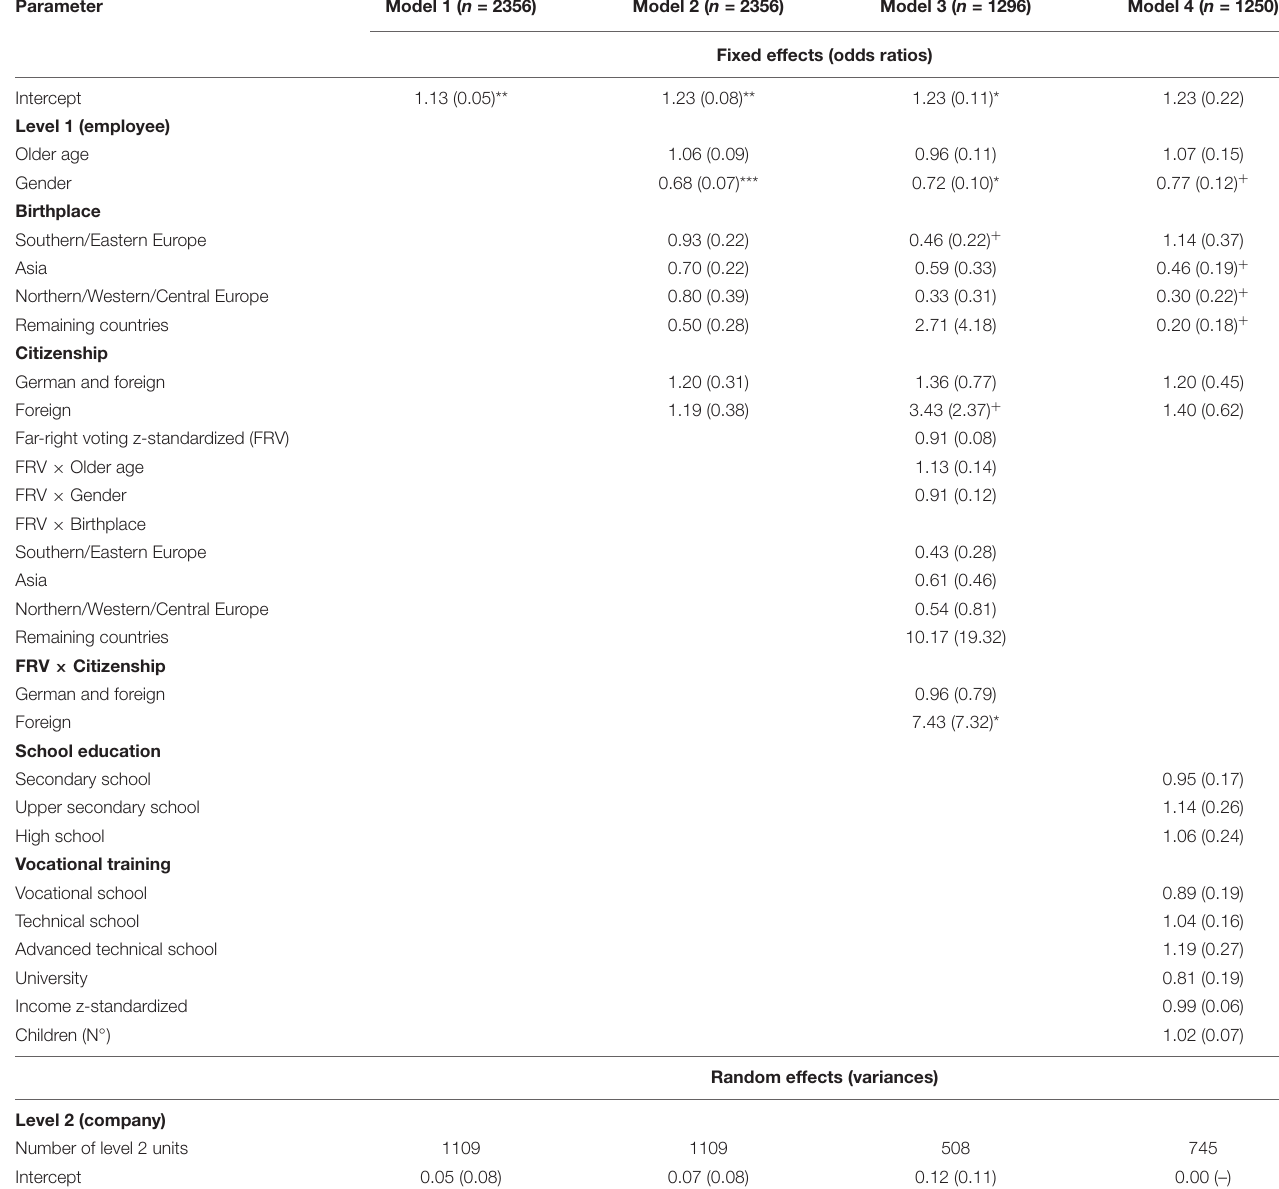
TABLE 4 | Mixed multilevel analyses for job offers with fixed effects and random intercepts for company as second level.